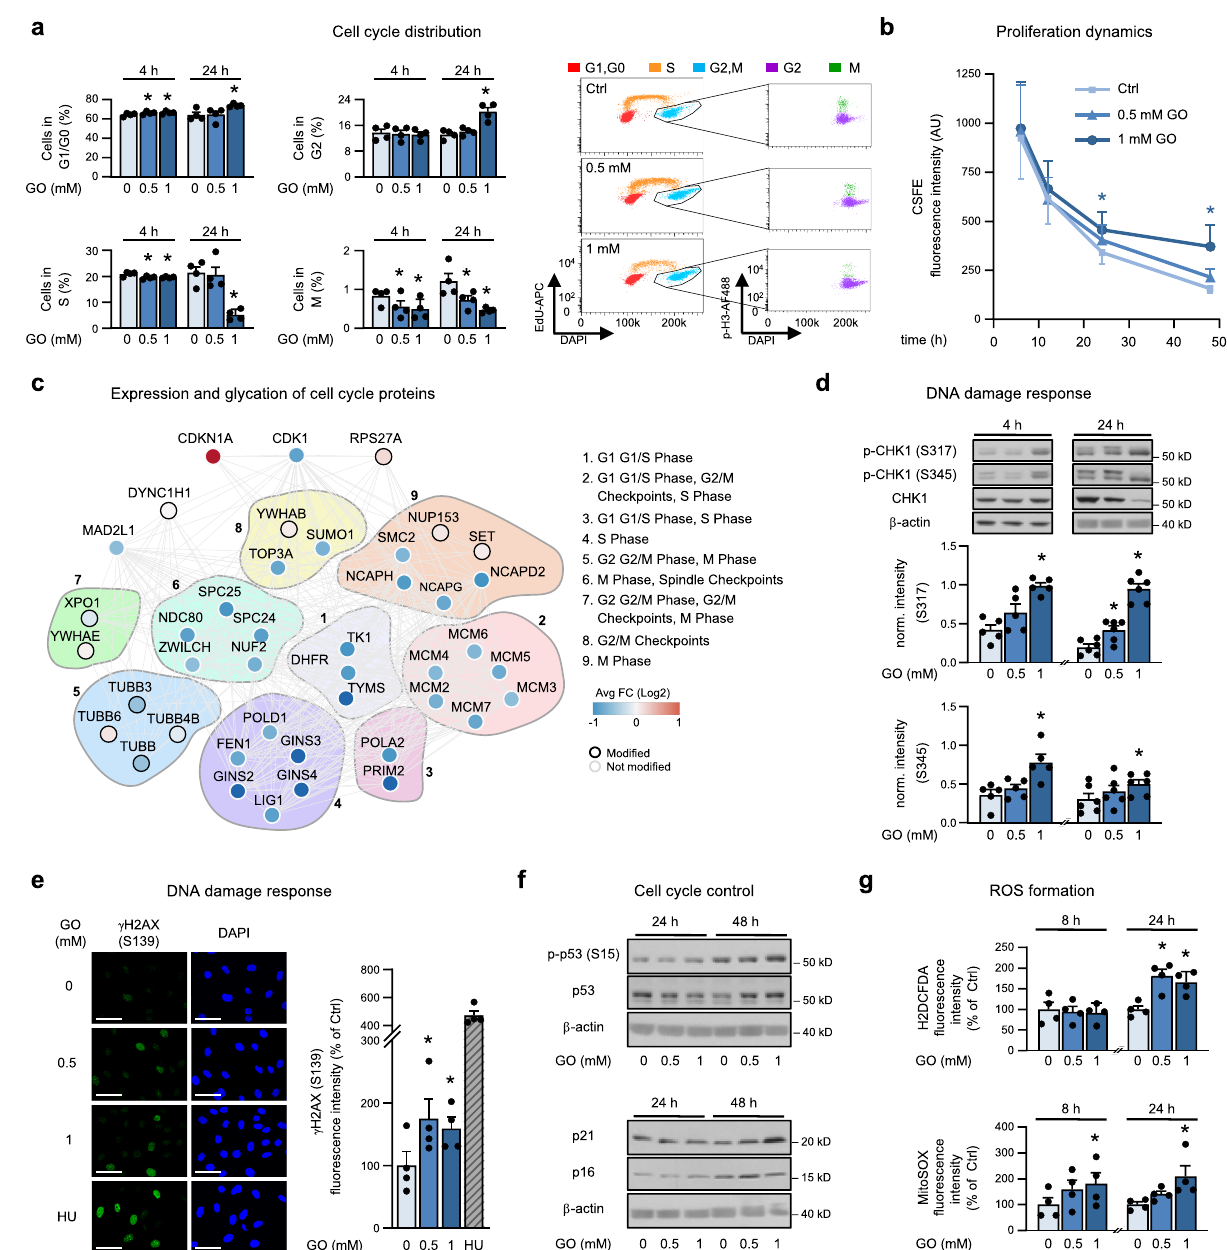
Fig. 5 Perturbation of the cell cycle induced by glyoxal. a HUVEC were treated with GO as indicated and subjected to cell cycle analysis applying a triple staining method (5-ethynyl-2 ′ -deoxyuridine (EdU), p-H3 (S10), 4 ′ ,6-diamidino-2-phenylindole (DAPI)). Ratio of cells in the respective cell cycle phases (left) and dot plots representative for the 24 h-values (right) are shown. n = 4. b HUVEC were stained with carboxy fl uorescein succinimidyl ester (CFSE) and treated with GO. CFSE staining was quanti fi ed by fl ow cytometry. n = 4. c Cell cycle proteins were chosen according to Reactome annotation divided by their speci fi c role in each phase. Only proteins with signi fi cantly altered expression (absolute fold change > 0.58 and q < 0.05) or modi fi ed by CML are shown. Each dot represents the protein fold change and the black edge signi fi es proven CML modi fi cation. n = 4. d GO-treated HUVEC were lysed and subjected to immunoblot analysis. n = 5 (4 h), n = 6 (24 h). e Following GO treatment of HUVEC (8 h), immuno fl uorescence staining of γ H2AX (S139) and DAPI was performed. Hydroxyurea (HU, 2 mM, 1 h) served as positive control. Representative pictures and quanti fi cation of γ H2AX (S139)-positive nuclei are shown. Ctrl: control. Scale bar = 50 µ m. n = 4. f HUVEC were treated with GO, lysed and subjected to immunoblot analysis. Densitometric quanti fi cation is shown in Supplementary Fig. 6c. n = 6. g HUVEC were treated with GO and intracellular (dichlorodihydro fl uorescein diacetate (H2DCFDA)) and mitochondrial ROS (MitoSOX) were measured by fl ow cytometry. n = 4. a, b, d, e, g. Bar graphs and the curve diagram show mean + SEM. Statistical signi fi cance was analyzed using one-way or two-way repeated measurement ANOVA corrected via Holm – Š idák method. For panel e the positive control (HU) was not included into ANOVA. * p < 0.05 vs. respective control. Source data are provided as a Source Data fi le. Speci fi c p values are listed in Supplementary Data 6. Related to Supplementary Fig. 6 and Supplementary Data